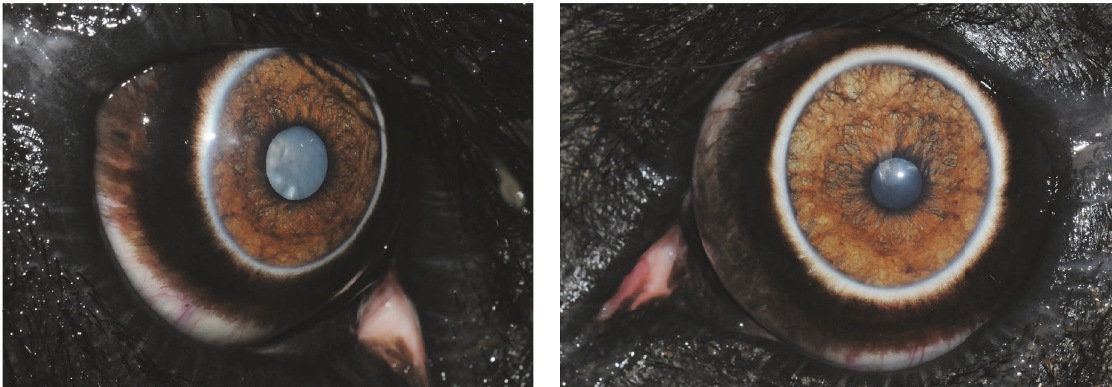
Figure 1: Ophthalmic reexamination six months after the initial examination in